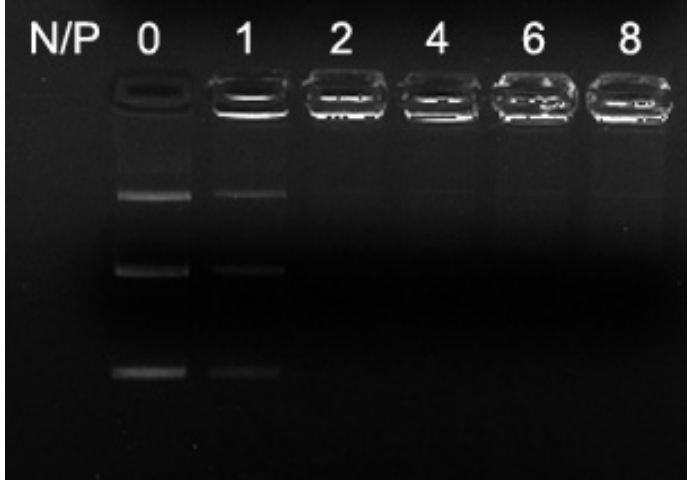
Figure 2. Electrophoretic gel retardation assays of pDNA binding for QM-SS-KK/DOPE/pDNA complexes under various N/P ratios.